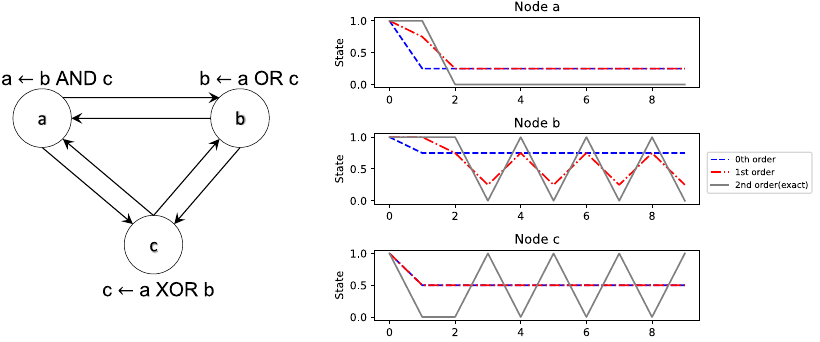
Fig. 6 An illustration of the relationship between nonlinearity and approximability using a simple 3-node Boolean network. The higher the order of nonlinearity of the network the more approximable it is with respect to the exact dynamics. Left: An example 3-node network utilizing all three 2-input Boolean functions. Right: The network is simulated from a single initial state of (1,1,1). Here the dynamics of the 0th order network (blue) least matches the exact Boolean trajectory (gray), while 1st order network (red) is a slightly better match. The 2nd order network (gray) is exact since it includes all the Taylor terms up to the maximum possible order of 2 (the maximum in-degree of any node). The closer the approximated average dynamics to the exact dynamics, the lower the MAE and the higher the approximability of the former. Notice also that while for node “ a ” the 0th order network is almost as good as the 1st order network, it is the opposite for node “ c ” in that its 1st order approximation is as poor as the 0th order; this is because “ c ” implements the XOR function whose 1st order derivatives are